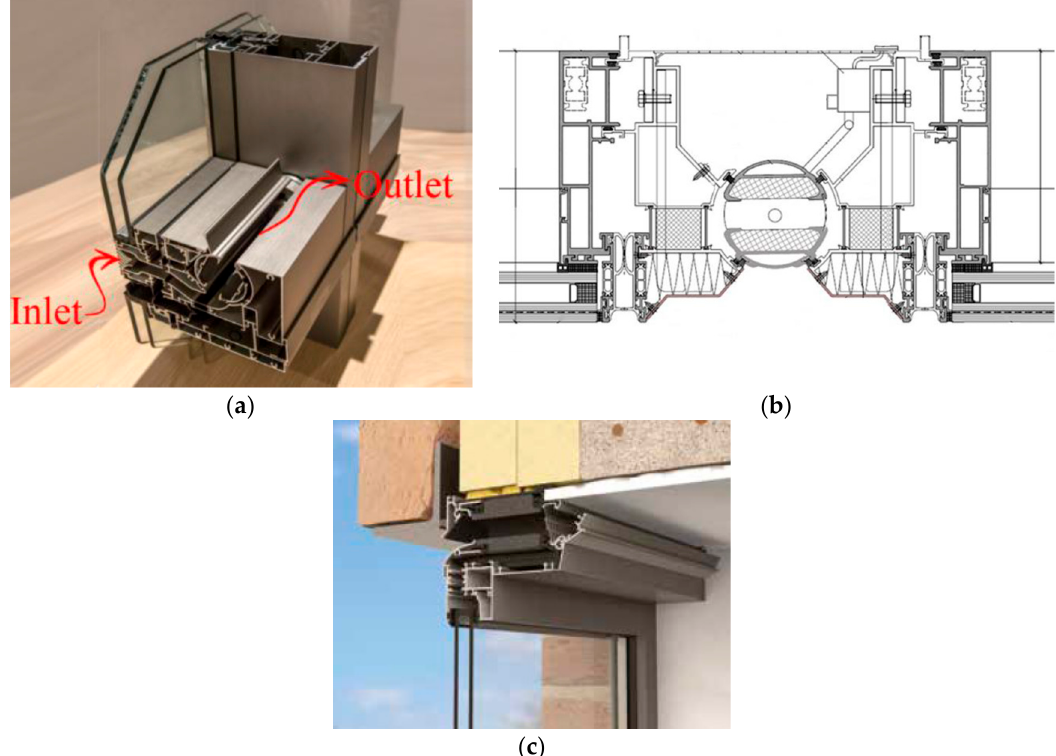
Figure 9. ( a ) A Trickle Vent applied to the bottom part of glazing [4]; ( b ) a vertical Trickle Vent [14]; ( c ) a Trickle Vent applied to the top part of glazing [48].